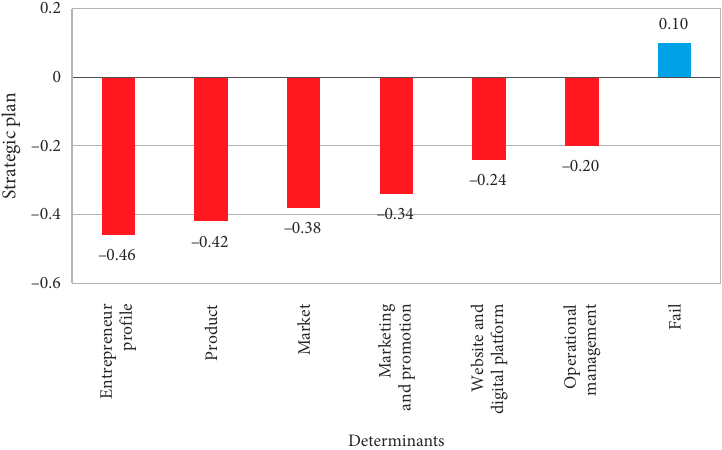
Figure 5. Impact on strategic plan of −0.50 variation in each cluster